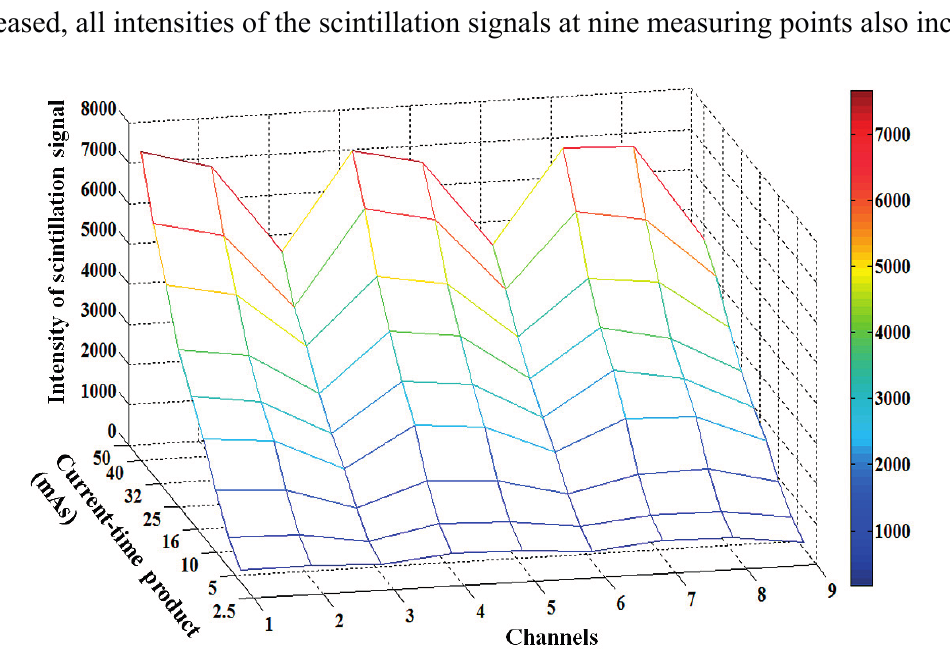
Figure 6. 3D intensity variation of nine scintillation signals measured by using the proposed phantom dosimeter at each measuring point according to the current-time